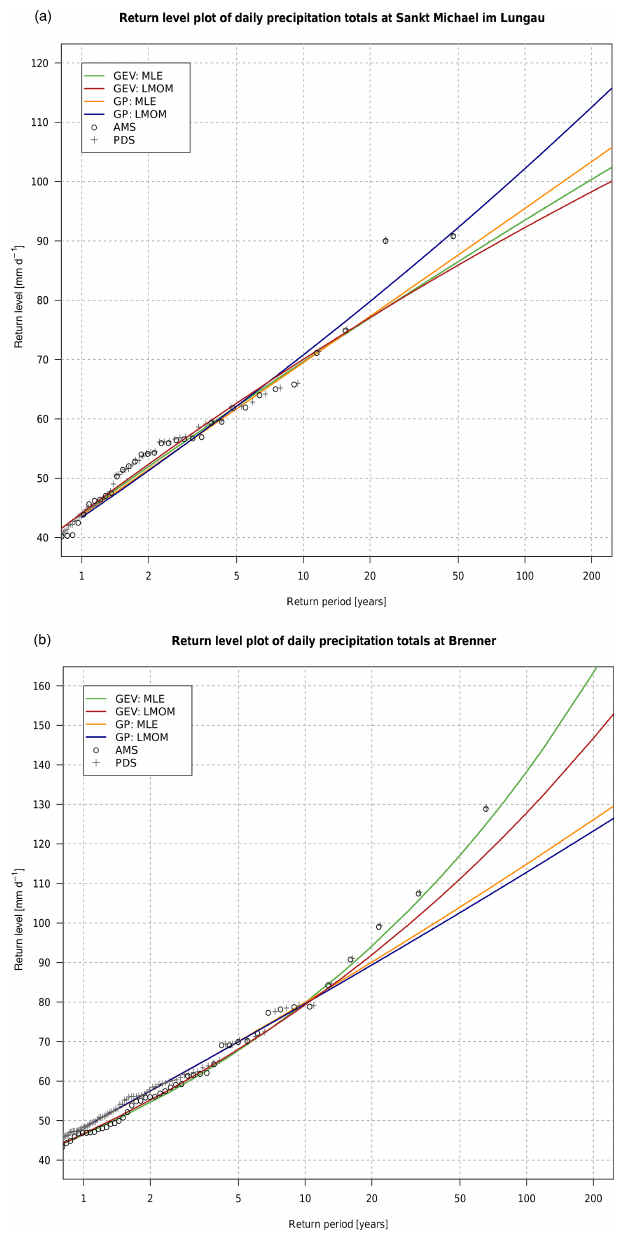
Figure 6. Return level plots of daily rainfall events at the hot spot in (a) Sankt Michael im Lungau, which is located in the Central Eastern Alps, and (b) Brenner pass, located at the Austro-Italian border. Return level estimation is based on the block maxima ap- proach and on the threshold excess approach with two different pa- rameter estimation methods (MLE and LMOM estimation). Based on the CRMSE 10 , GP fitted on the basis of LMOM estimation was found to be the most appropriate method for Sankt Michael, while GEV with MLE was found to be most suitable at Brenner. Please note that functions are plotted without associated confidence inter- vals for the sake of